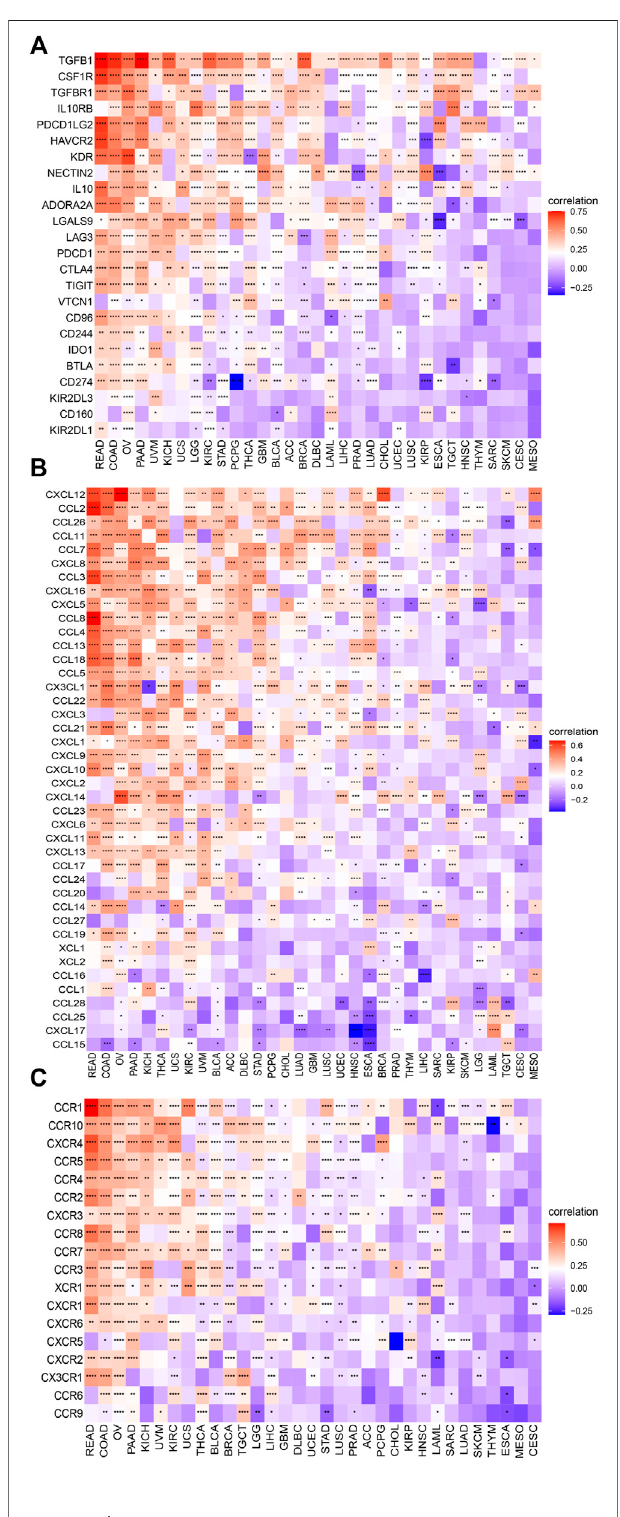
FIGURE 7 | C1QTNF6 is correlated with immune-associated genes. The heatmap demonstrating the correlation between the C1QTNF6 expression level and (A) immunosuppressive genes. (B) chemokine genes. (C) chemokine receptors. * p < 0.05, ** p < 0.01, *** p < 0.001, **** p <